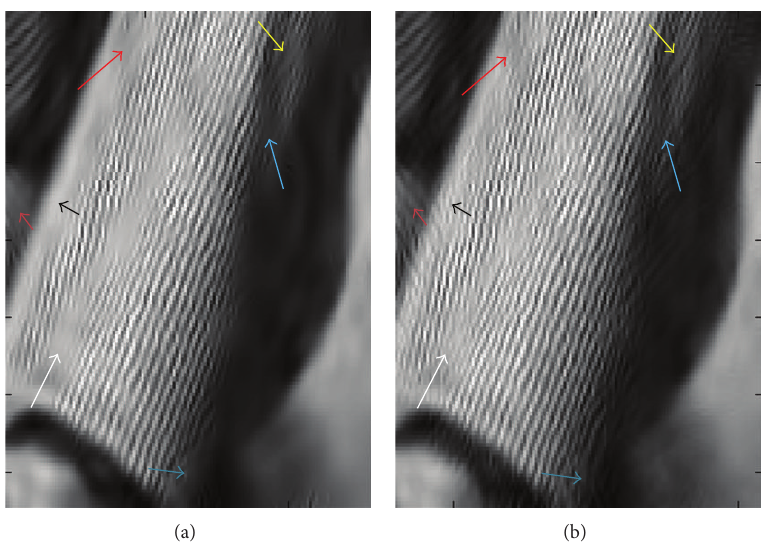
Figure 17: (a) shows a part of Barbara image denoised using BiShrink [45] for stationary noise with 𝜎 𝑛 = 40 and (b) shows denoised image using our method. Comparing the area around the corresponding arrows, we understand that our method is able to better preserve the details of images.